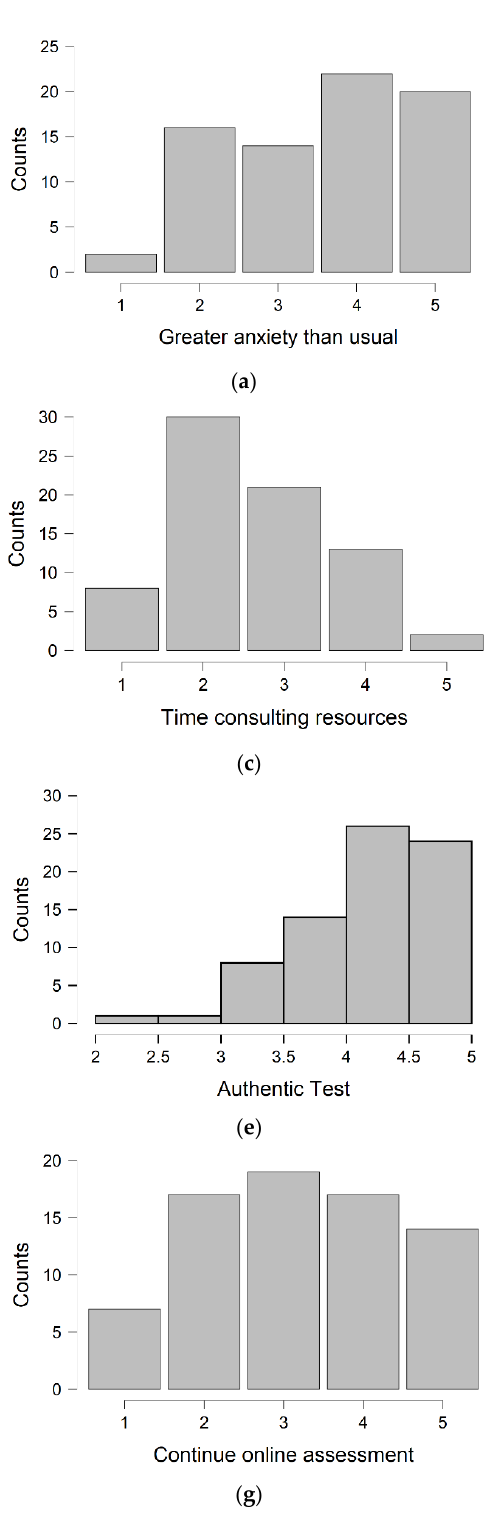
Figure 2. Distribution of participant responses to survey items. ( a ): Greater anxiety than usual; ( b ): Time preparing online than usual ; ( c ): Time consulting resources; ( d ): Supportive enviroment; ( e ): Authentic Test; ( f ): Welcome continued online delivery? ( g ): Continue online assessment.